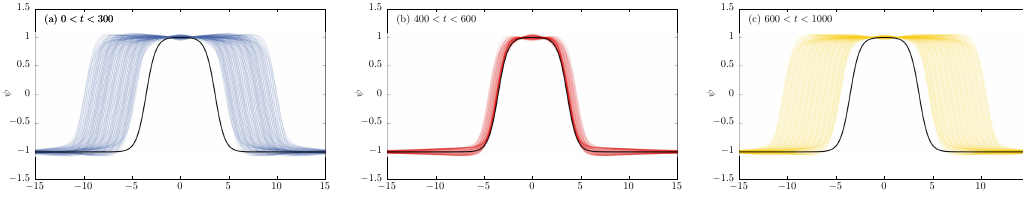
Figure 7 . Evolution of the field ψ obtained in the scattering of the initial configuration (5.1)–(5.2) with the pink mode ( n = 8) initially excited. Here A = 0 . 078 and solitons form a long living stationary solution ( t ∈ [400 , 700] ) localized at the BPS solution with b = 321 .